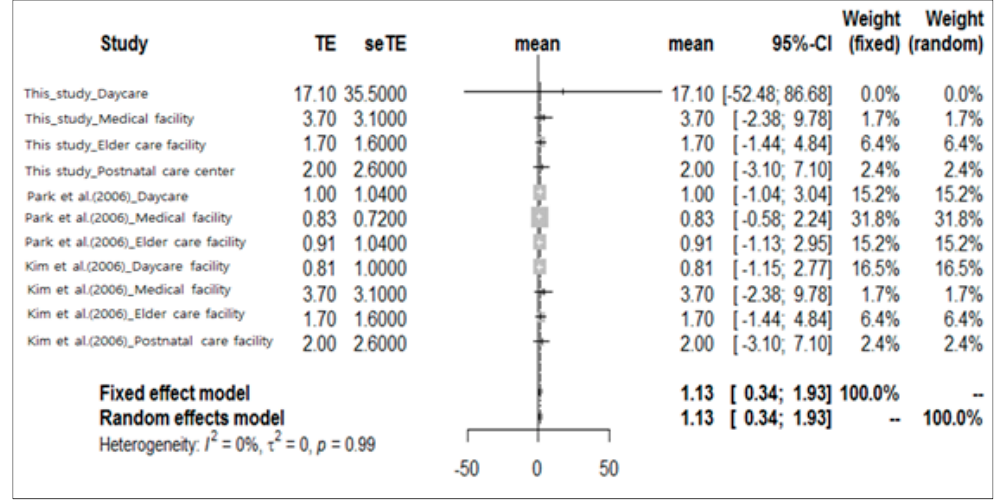
Figure 3. Indoor/outdoor airborne bacterial concentration ratio for each target facility.